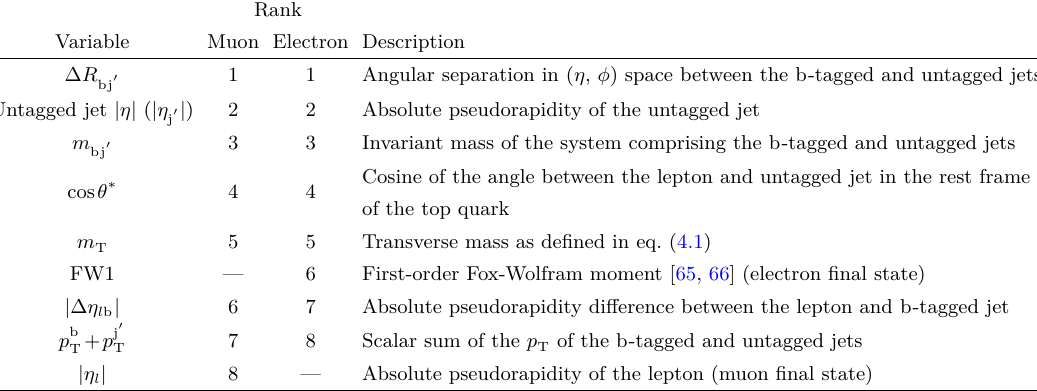
Table 2 . BDT input variables ranked in decreasing order of their SP values for the muon and electron final states in the 2J1T